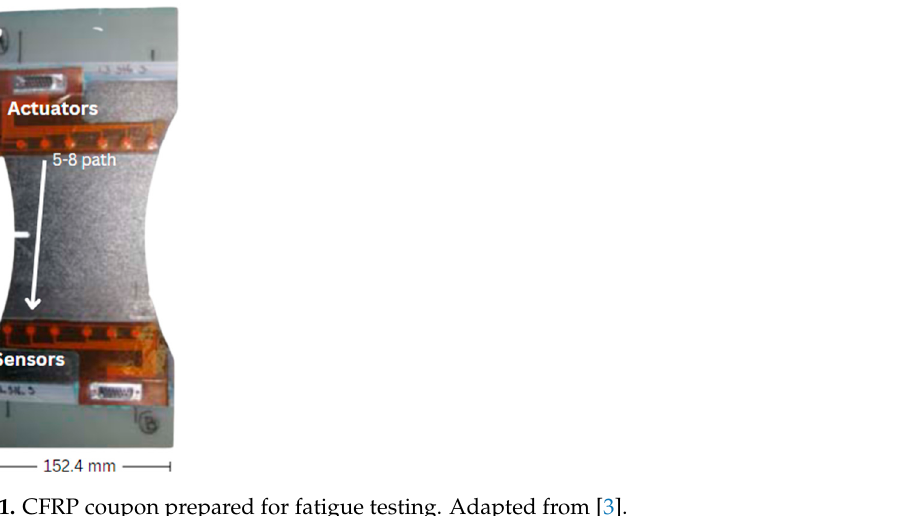
Figure 1. CFRP coupon prepared for fatigue testing. Adapted from [3].